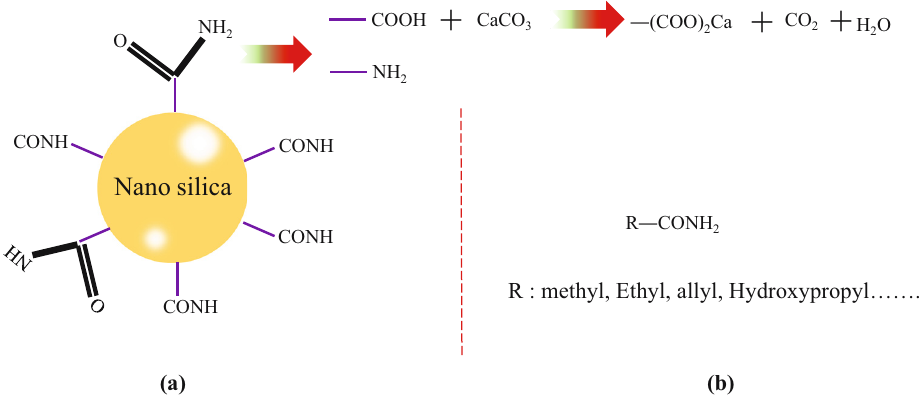
Figure 5: Comparison of molecular structures and functional di ff erences of two acid gelling agents. ( a ) Structure of nano silica gelling agent and reaction mechanism; ( b ) structure of commercially available gelling agents.